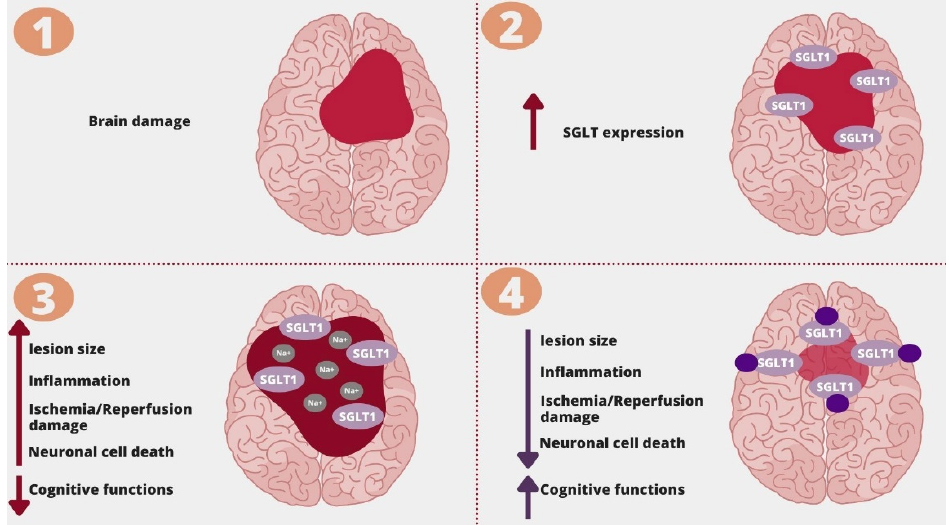
Figure 4. SGLT1 inhibition and ischemic brain damage. 1. Brain damage; 2. In the area of brain damage, there is an increase in the expression of SGLT1; 3. Sodium influx through SGLT1 receptors is associated with increased ischemia/reperfusion damage, lesion size, edema, inflammation, neuronal cell death, and decline in cognitive functions; 4. SGLT receptor blockage/knockdown was associated with improvement in damages caused by ischemia and ischemia/reperfusion damage.